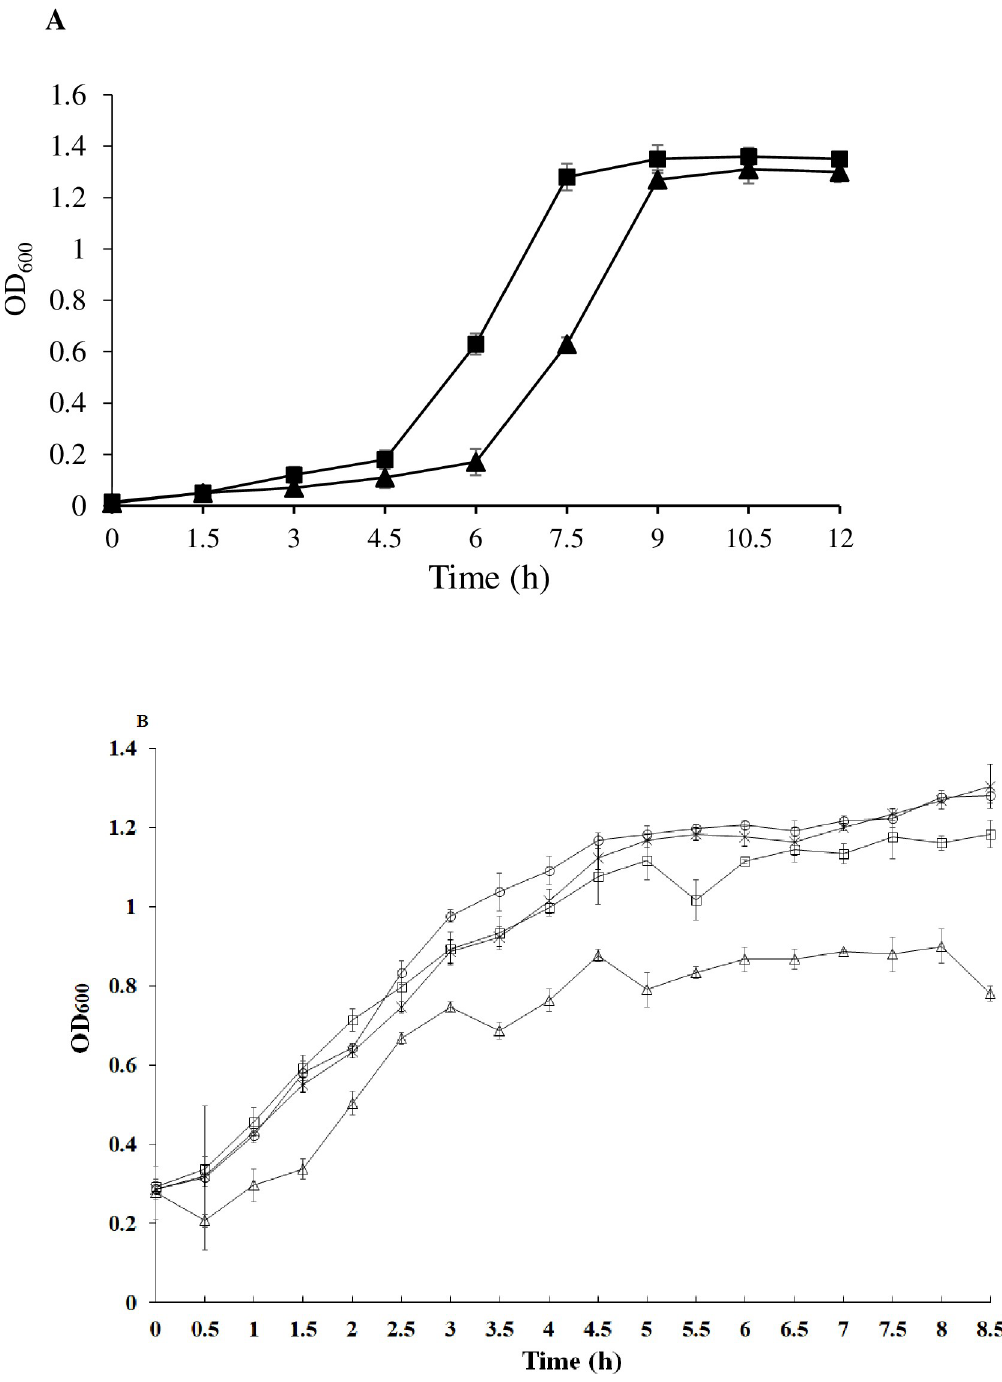
Fig 1. Growth curves and phage lysis effect in host strain. (A) Lm3-22- Δ rliB mutant ( ) and wild-type Lm3-22 ( ) were inoculated on BHI agar (Cm, 10 μ g/mL) and cultured overnight at 37˚C. (B) Host bacteria were infected with phages at an MOI of 100, and the concentration (OD 600 value) of host bacteria was determined every 30 minutes. Lm3-22 control ( ), Lm3-22- Δ rliB control ( ), Lm3-22 with phage ( ), and Lm3-22- Δ rliB with phage ( ). Values correspond to the mean from three independent experiments.